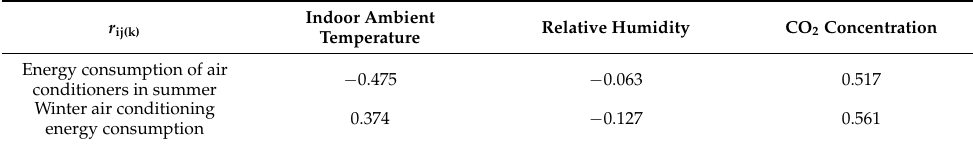
Table 10. Partial correlation analysis results.